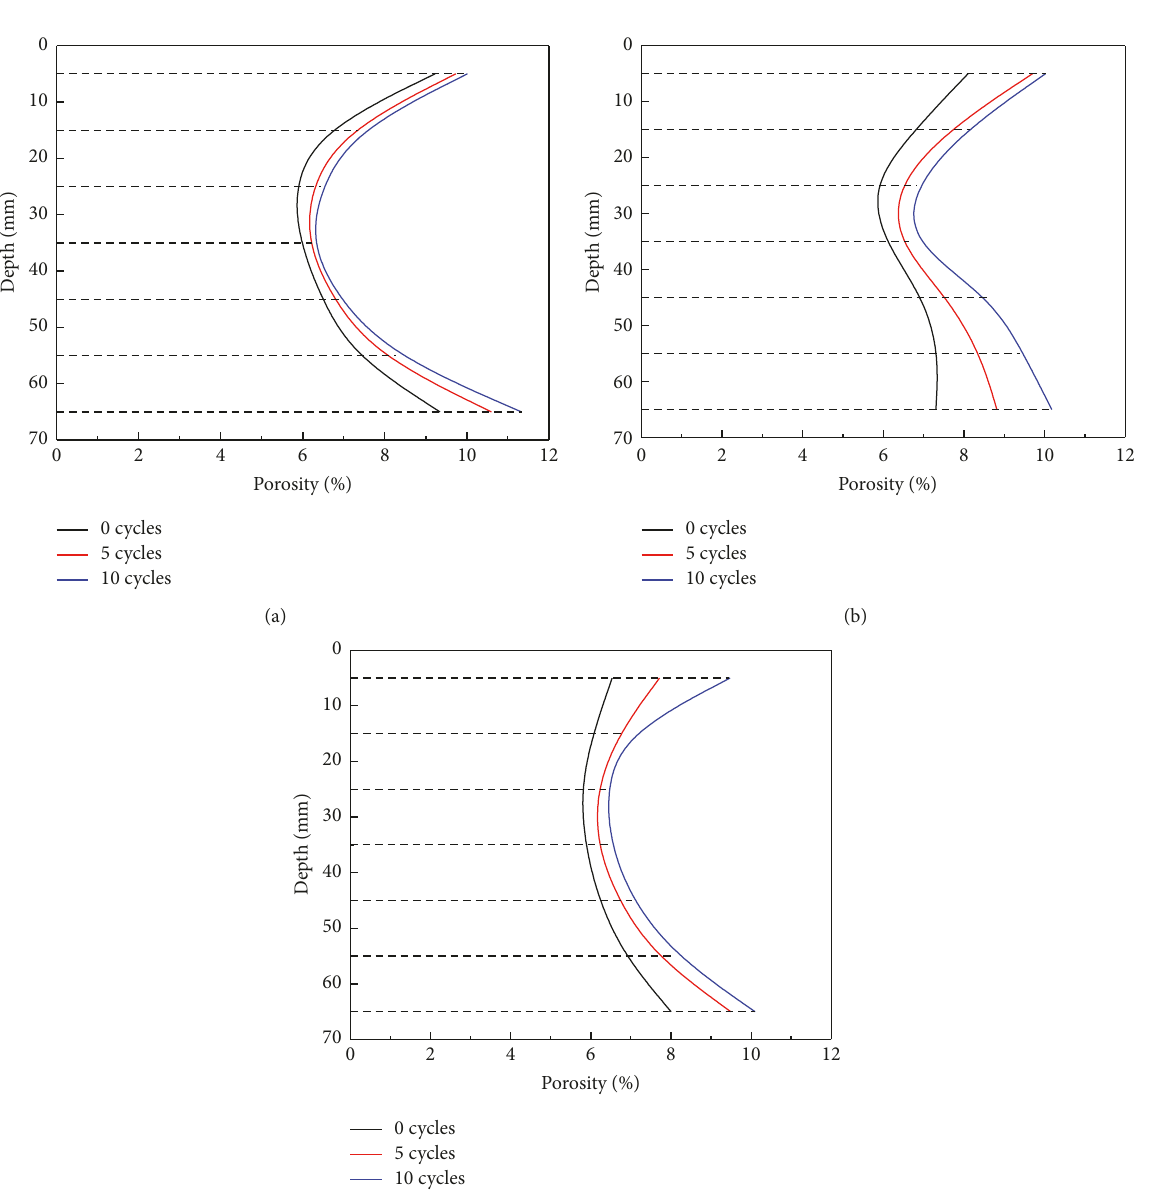
Figure 3: Porosity distributions of the different samples after 28 d of curing: (a) cement content = 4.0%; (b) cement content = 4.5%; (c) cement content =